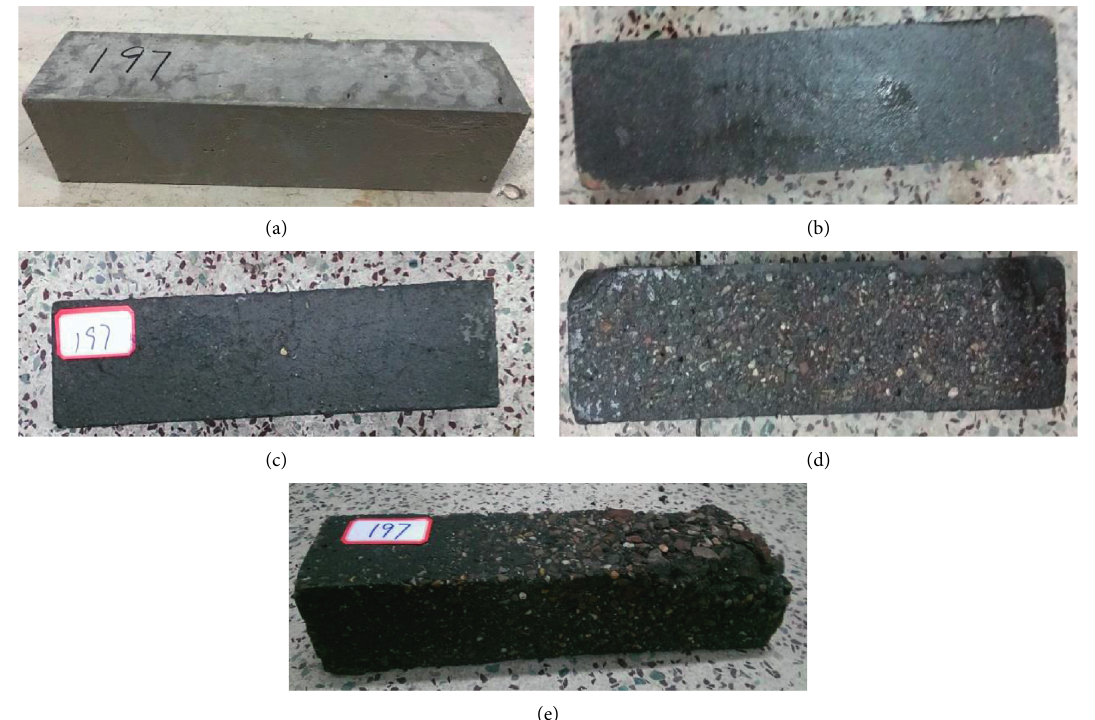
Figure 1: Typical failure modes of the concrete in the IFTenvironment. (a) 0 freeze-thaw cycles; (b) 25 freeze-thaw cycles; (c) 50 freeze-thaw cycles; (d) 75 freeze-thaw cycles; and (e) 125 freeze-thaw cycles.